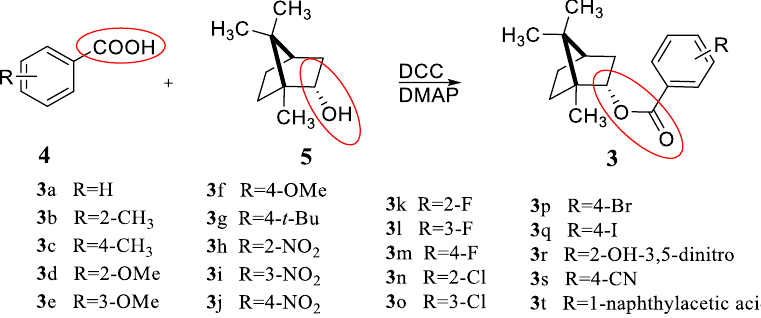
Scheme 1. Synthetic route for tschimganin analogs 3 .